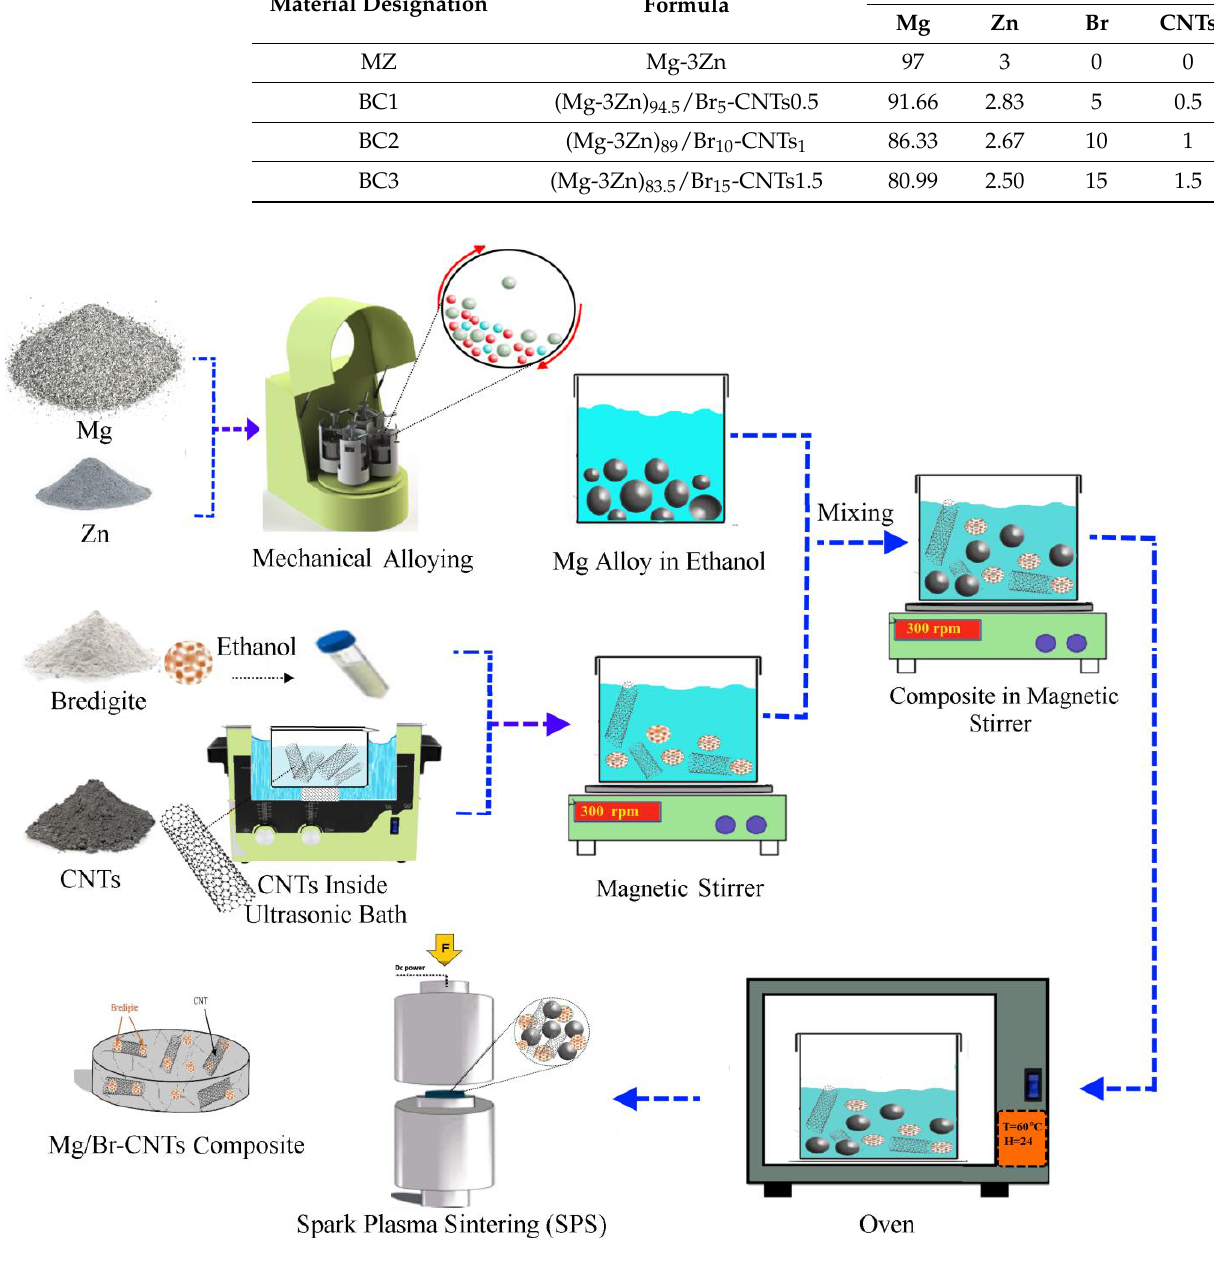
Figure 1. Schematic representation of the fabrication process of MZ/Br-CNT composites using SPM, and SPS methods.